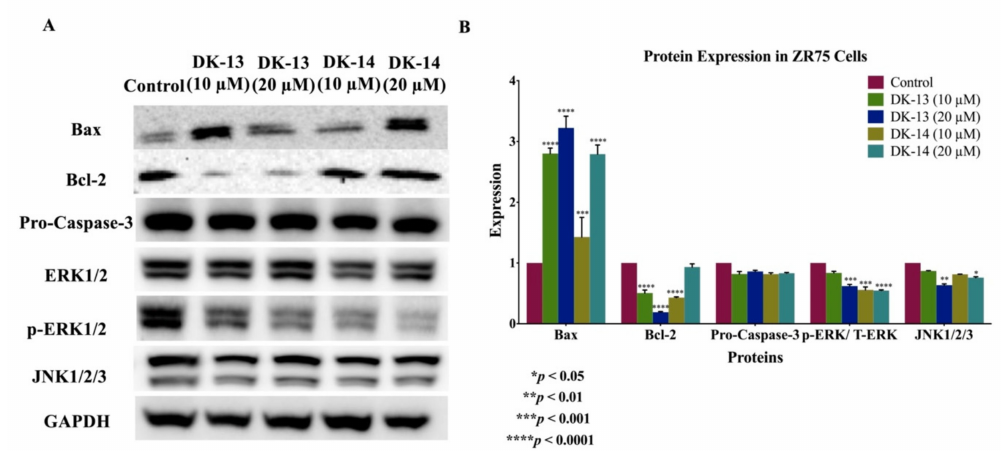
Figure 7. ( A , B ). Protein expression and molecular mechanisms of chalcone compounds (DK-13 and DK-14) inhibitory actions in ZR75 cell line. These compounds induce the expression of pro-apoptotic markers Bax and Caspase-3 in comparison with their control, while anti-apoptotic marker Bcl-2 is inhibited. Furthermore, DK-13 and -14 inhibit the expression of both, JNK1/2/3 and ERK1/2. GAPDH was used as a control in this assay. Cells were treated with 10 and 20 µ M of DK-13 and -14 compounds for 48 h, as explained in the Materials and Methods section. ( A ) Blot image and ( B ) quantification of bands.